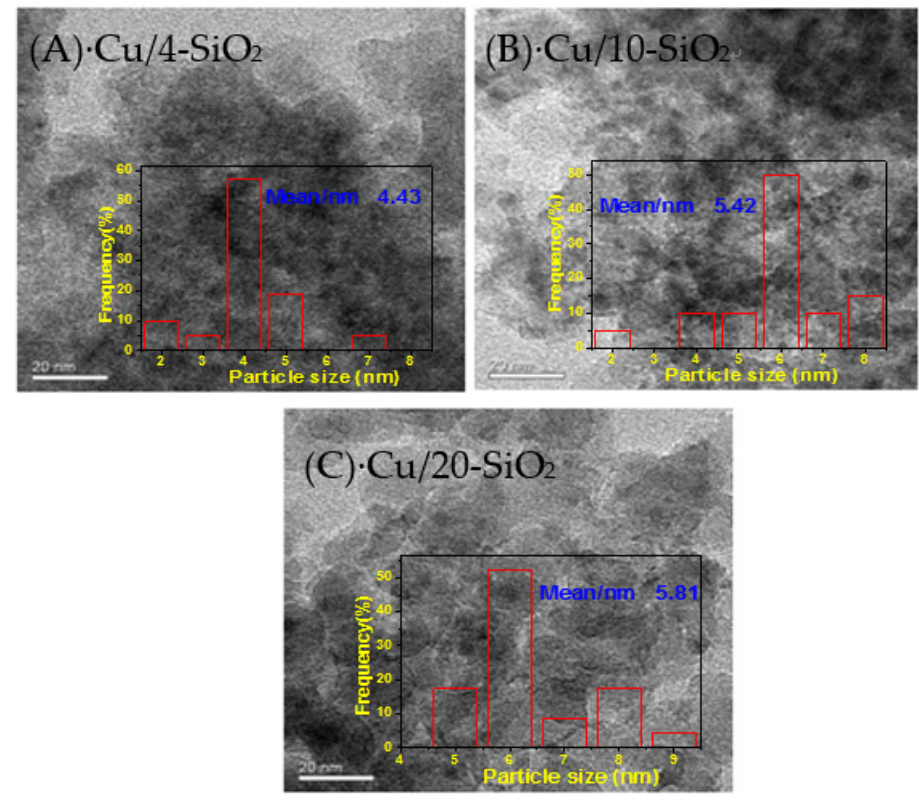
Figure 4. TEM images of the reduced Cu/x-SiO 2 . ( A ) Cu/4-SiO 2 ; ( B ) Cu/10-SiO2; ( C ) Cu/20-SiO 2